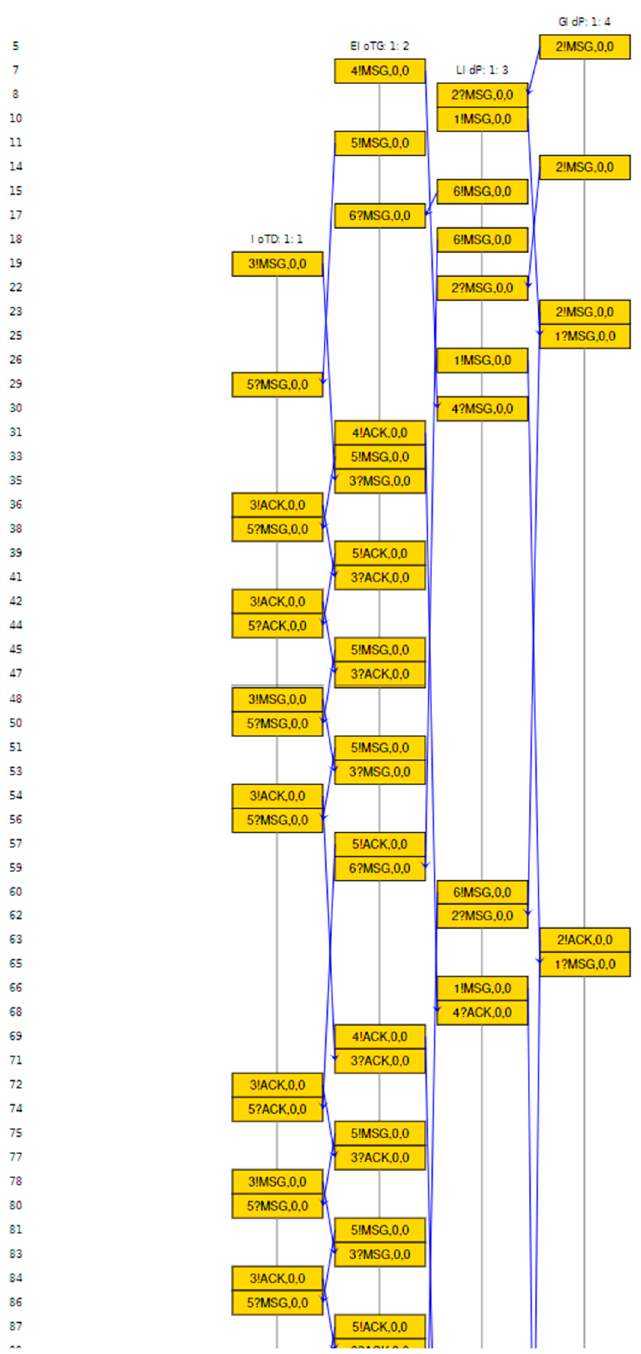
Figure 21. Simulation results for communication between IoTD, EIoTG, LIdP and GIdP using SPIN.